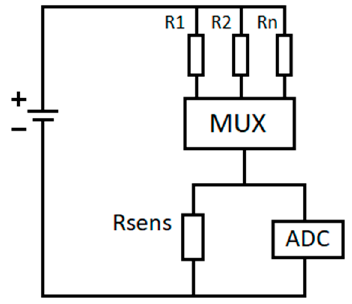
Figure 3. Voltage divider configuration used to measure the lab-made sensor resistance. Rsens represents the sensor resistance, which varies with the concentration of the target gas. R1, R2, and Rn are resistances with di ff erent and known values and are selected through the multiplexer (MUX) to keep the voltage measured by the analog-to-digital converter (ADC) in the maximum accuracy range.